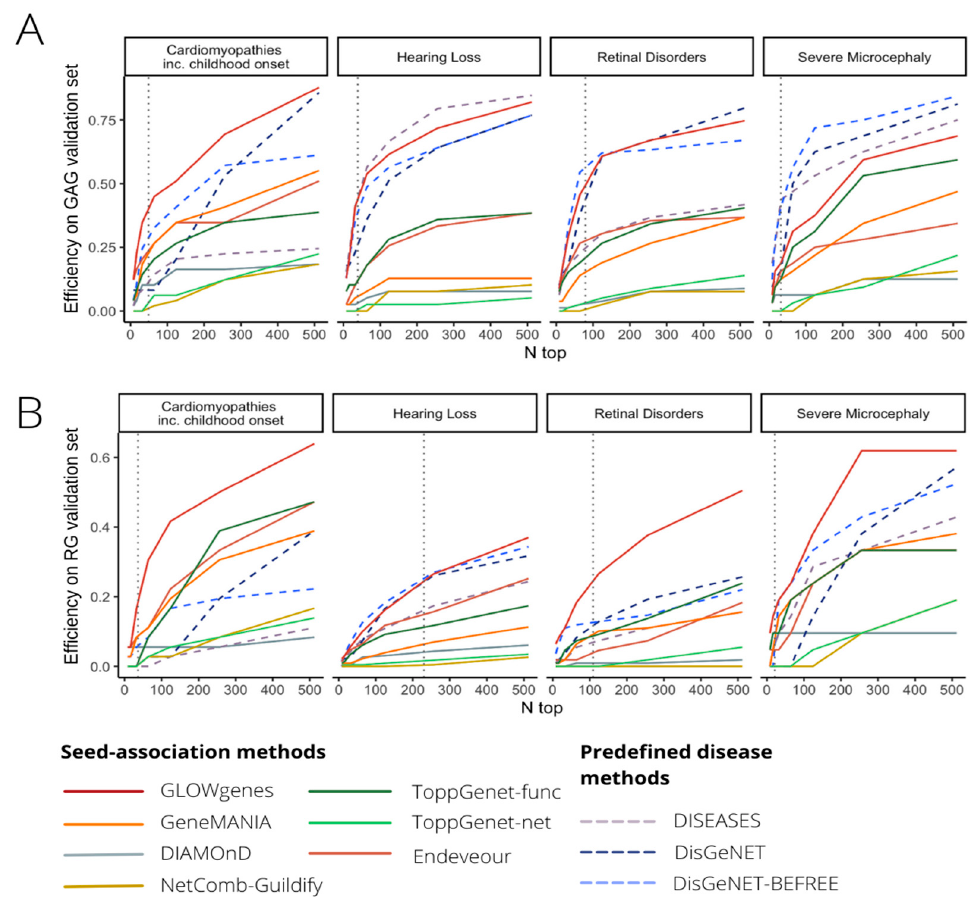
Figure 6. Benchmarking of tools for disease candidate genes prioritization. ( A ) Comparative eval- uation of 10 tools for the prioritization of gene disease candidates using Green–Amber genes from PanelApp (GAGs, high evidence disease-associated genes) for validation in four selected diseases (pilot diseases). Recall levels at different n-top genes are represented. ( B ) Same to A, but using red genes from PanelApp (RGs, low-evidence disease-associated genes) as validation sets .